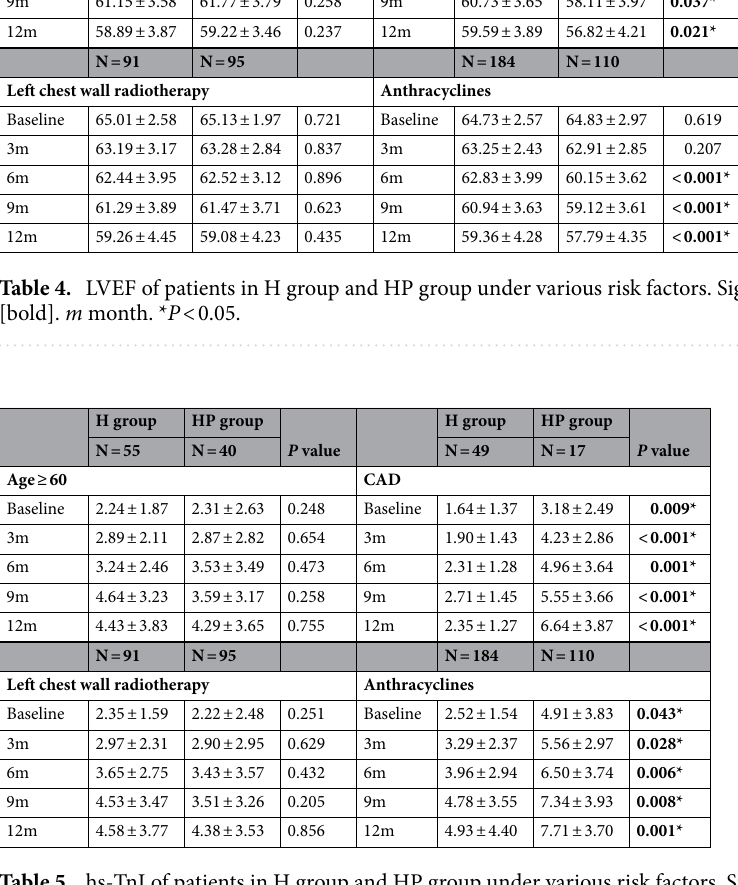
Table 5. hs-TnI of patients in H group and HP group under various risk factors. Significant values are in [bold]. m month. * P < 0.05.